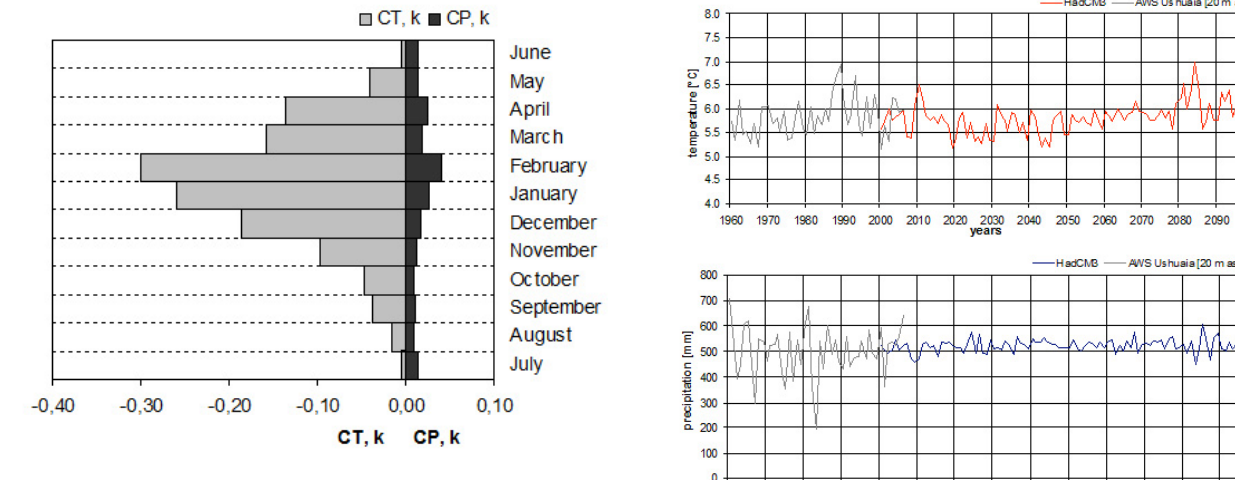
Fig. 5. Seasonal sensitivity characteristic for Martial Este Glacier, calculated with a degree-day model. The sensitivity of the specific balance for monthly perturbations is denoted by C T,k and C P,k . The indices refer to air temperature ( T ), precipitation ( P ) and the month ( k =1,...,12). The precipitation sensitivity coefficient was divided by a factor of 10.